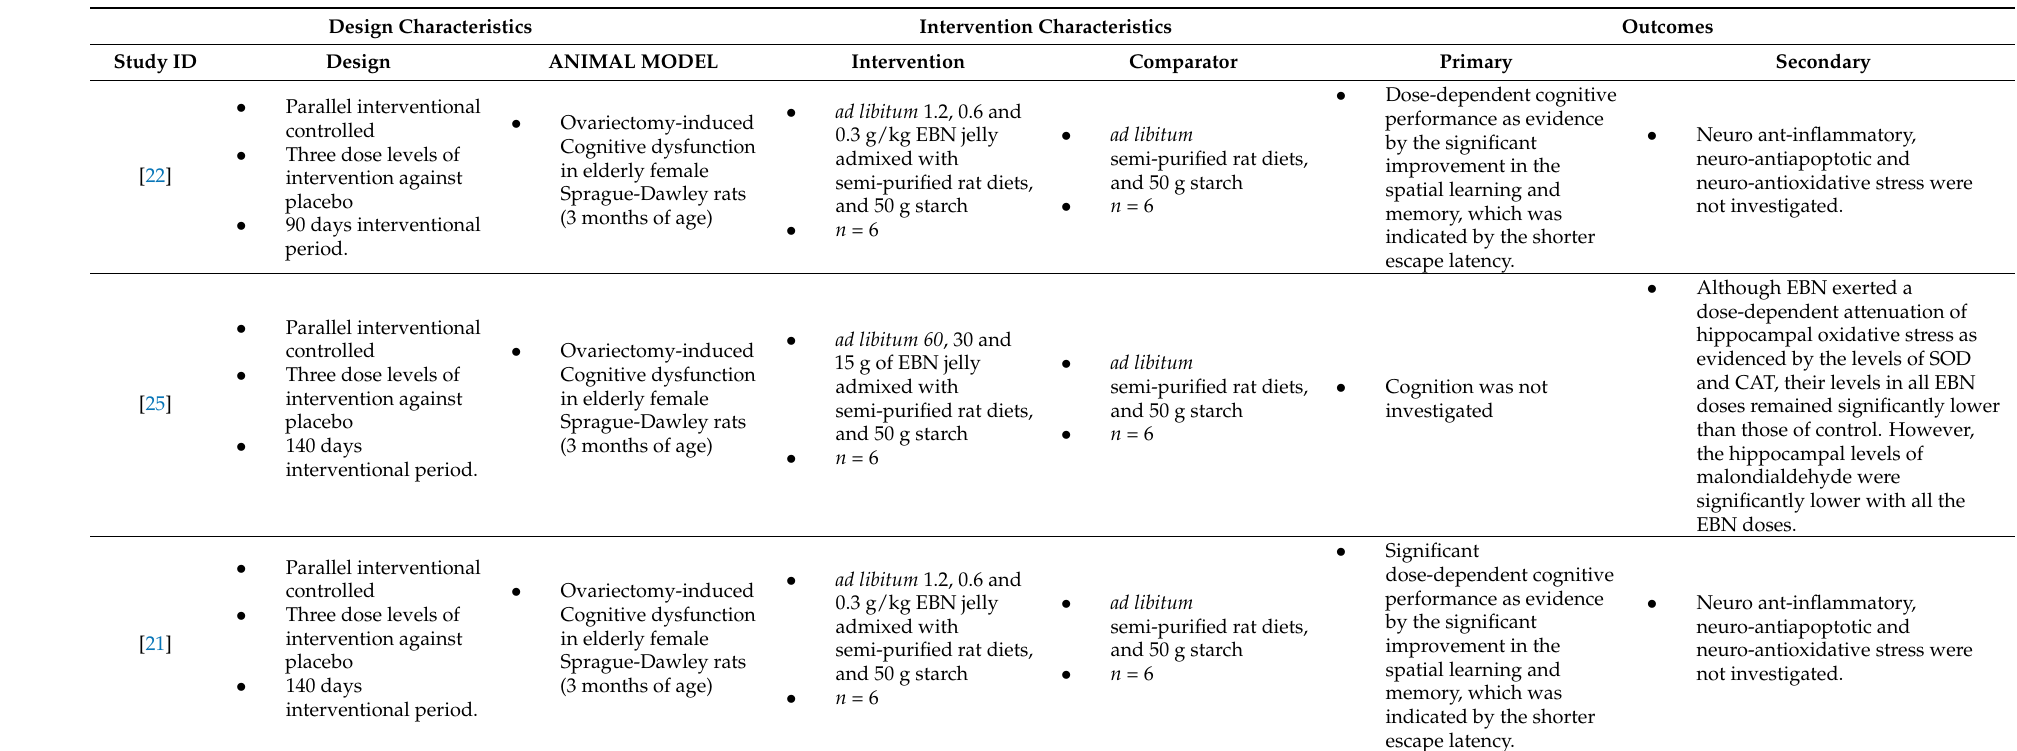
Table A1. Study characteristics and extracted